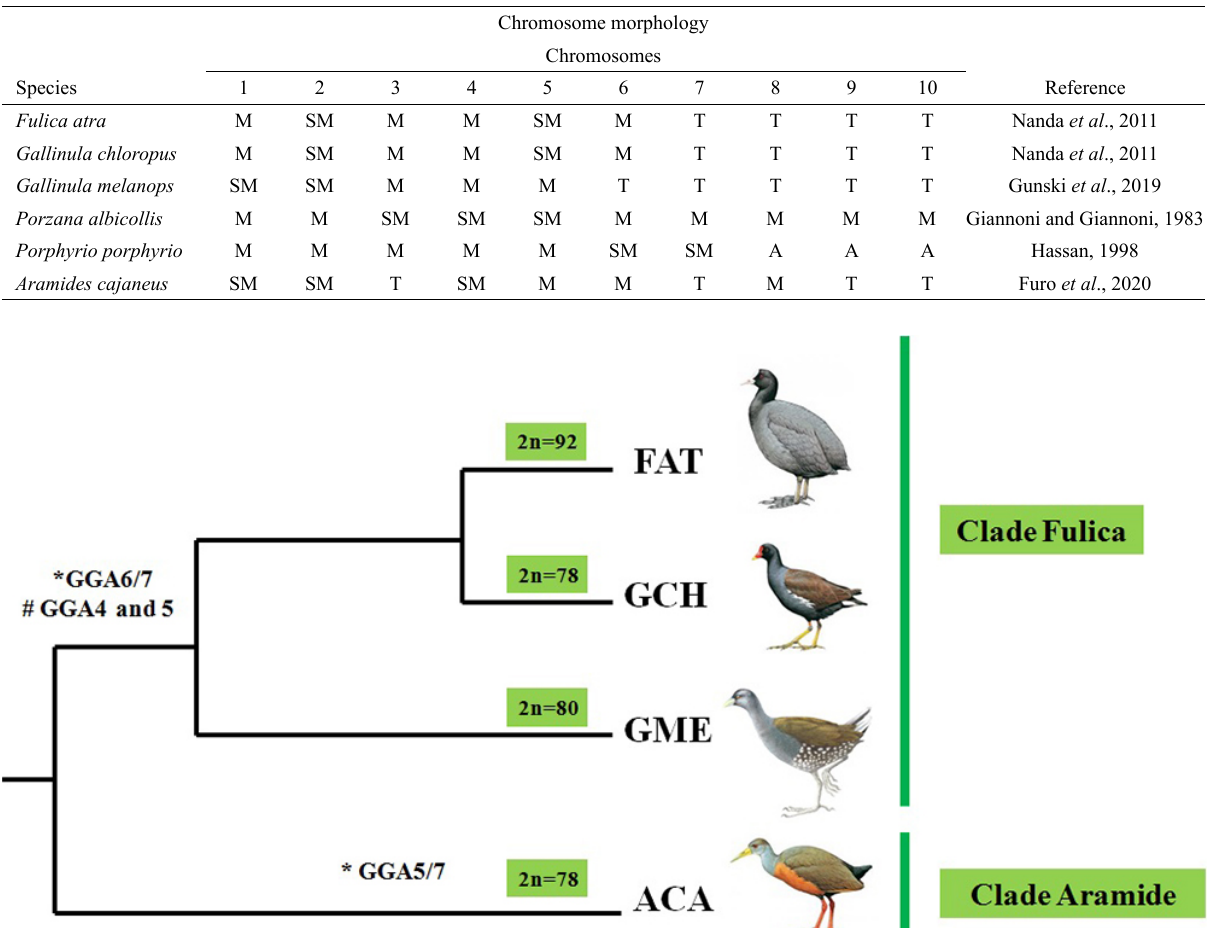
Table 3 – Morphological classification of macrochromosomes of five species belonging to the Rallidae family. Legend: M- Metacentric; SM- Submetacentric; T-